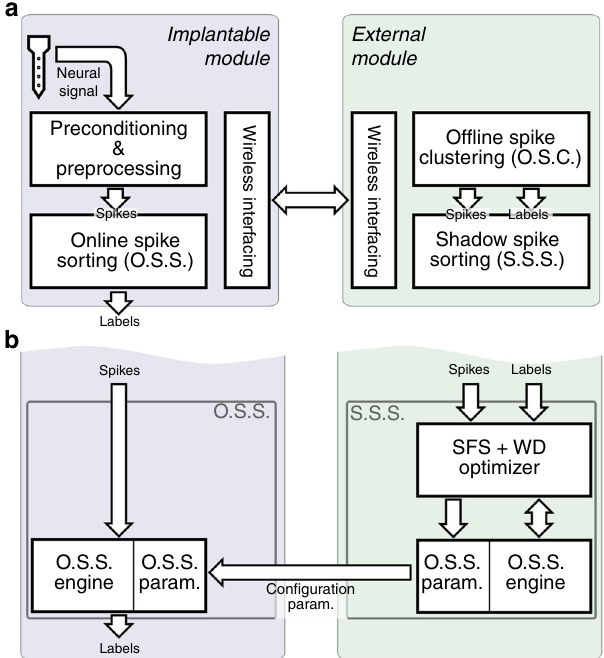
Fig. 2 Functional diagram for the implementation of the proposed online spike sorting approach on an implantable neural recording system. a The Implantable Module contains an online spike sorting module that needs to be con fi gured by a shadow spike sorter block on the external module. In the training phase, the of fl ine spike clustering block on the external side of the system receives a long-enough recording on all the channels, and performs unsupervised spike sorting in order to identify all the units (spike classes) in the brain area under recording. Outcome of this of fl ine spike clustering is the identi fi ed spike classes and the associated labels, which are used to optimize a model of the proposed method (the shadow spike sorter). b The shadow spike sorter block is indeed a model of the salient feature selection method followed by window discrimination (SFS + WD), which is optimized using the spike class information it receives from the of fl ine spike clustering block. After optimization, settings and functional parameters of the shadow spike sorter are used to con fi gure the main online spike sorter on the